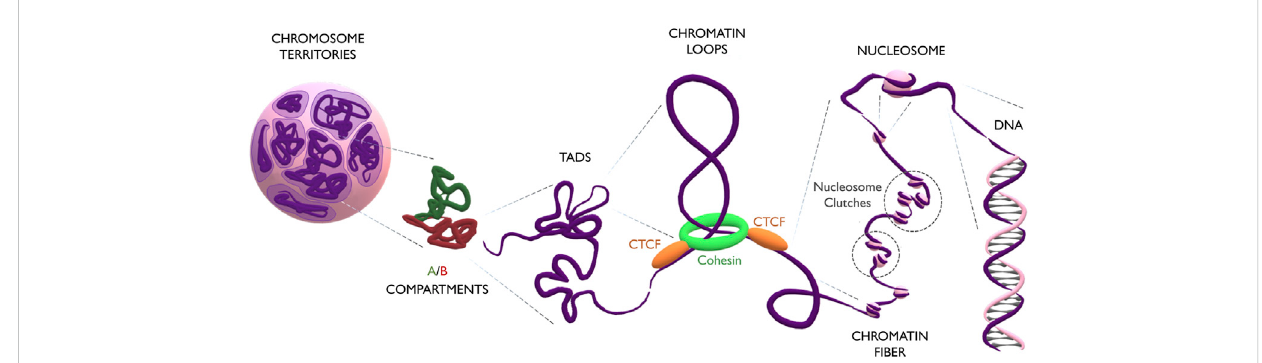
FIGURE 1 The multilayered organization of DNA. Schematic representation of genome folding at multiple scales. Chromosomes (in purple) occupy discrete areas called chromosome territories. Inside each chromosome, active A compartments (in green) segregate from inactive B compartments (in red). CompartmentsorganizeintobigTADs(~Mb)andsmallerloops(~kb).Loopsformbytheextrusionofchromatinthroughthecohesinring(ingreen)which fi nally stalls at CTCF anchoring points (in orange). The loop is constituted by the chromatin fi ber, which contains heterogeneous groups of nucleosome clutches interspersed along the genome (highlighted in dashed circles). Nucleosomes (pink spheres) are formed by a histone core, around which the DNA helix is